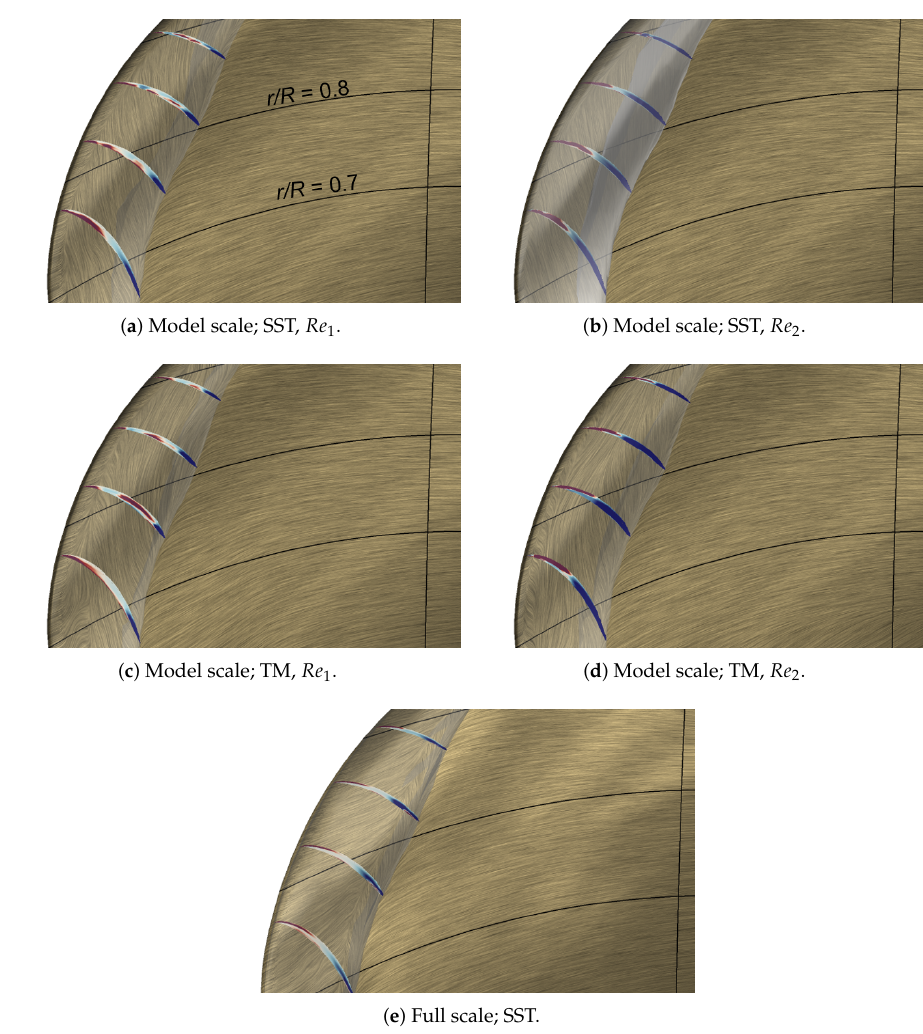
Figure 25. Rate of evaporation [kg/m 3 s] within the cavity volume in model and full scale for the PPTC Case 1. Closer view near the LE. The color scale is the same as in Figure